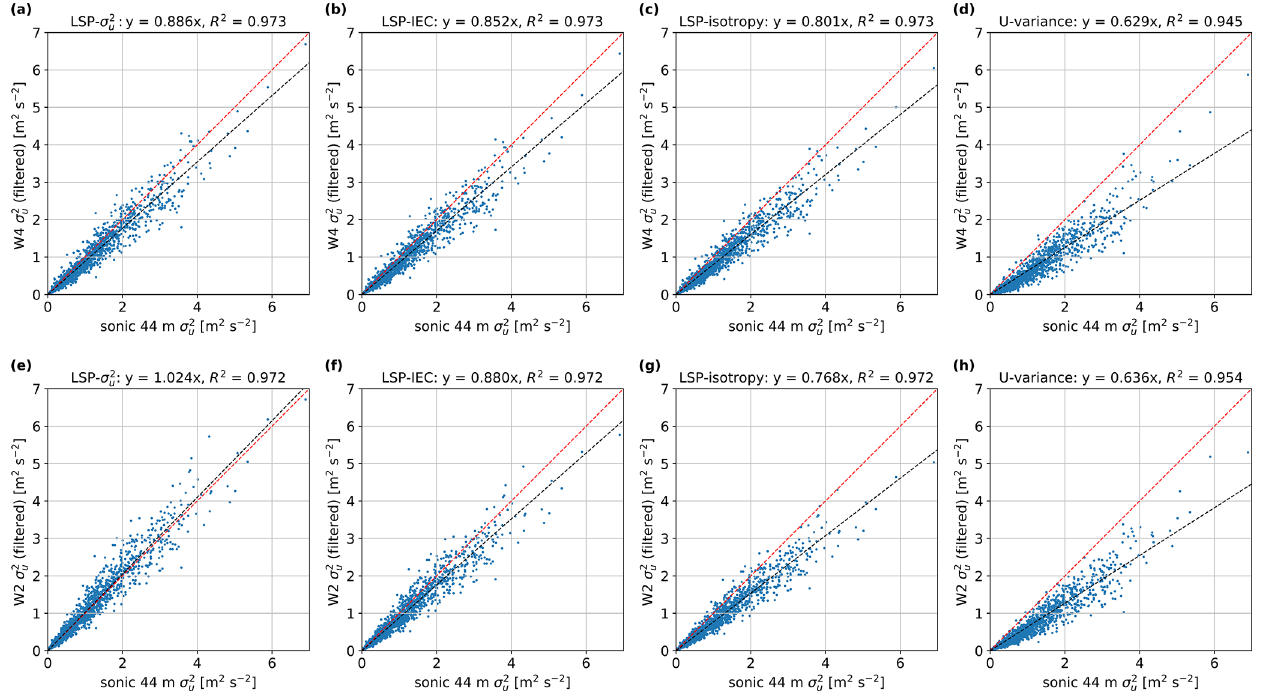
Figure 16. Comparison of the filtered variance of the along-wind velocity component between the Windar lidars and the sonic anemometer at 44m. (a–d) W4. (e–h) W2. Table 2. Bias and coefficient of determination between the lidar-derived along-wind velocity variance using different lidars and methods and that from the sonic anemometer at 44m. Lidars Methods Bias [%] Coefficient of the determination [%]